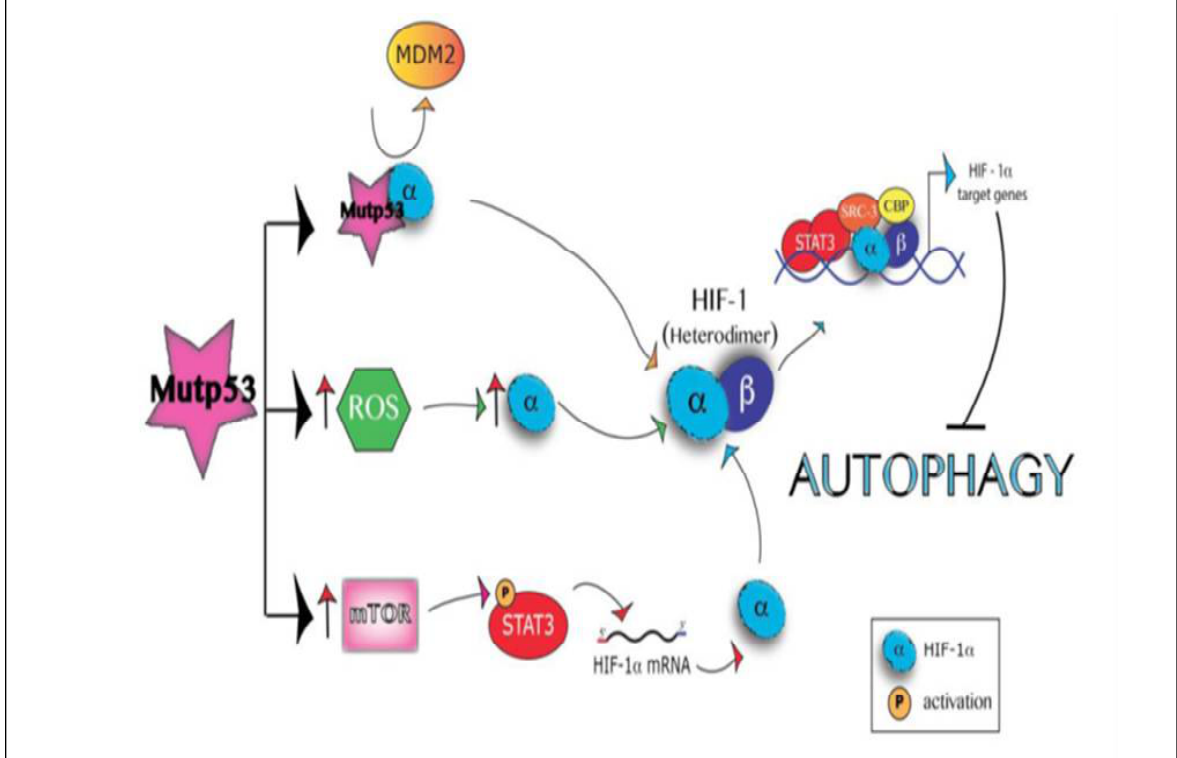
Figure 2: Schematic representation of the mechanisms at the basis of the stimulation of HIF-1 and HIF1- target genes by mutp53 resulting in autophagy inhibition. Regulation of HIF-1  pathway at different levels. (a) Growth factors related pathways; (b) pVHL related pathways; (c) FIH-1 pathway; (d) Mdm2-p53 mediated ubiquitination and proteasomal degradation pathway. (Cordani M, Butera G, Pacchiana R, Donadelli M. Molecular interplay between mutant p53 proteins and autophagy in cancer cells. BBA - Reviews on Cancer 2016; 8: 1-34.